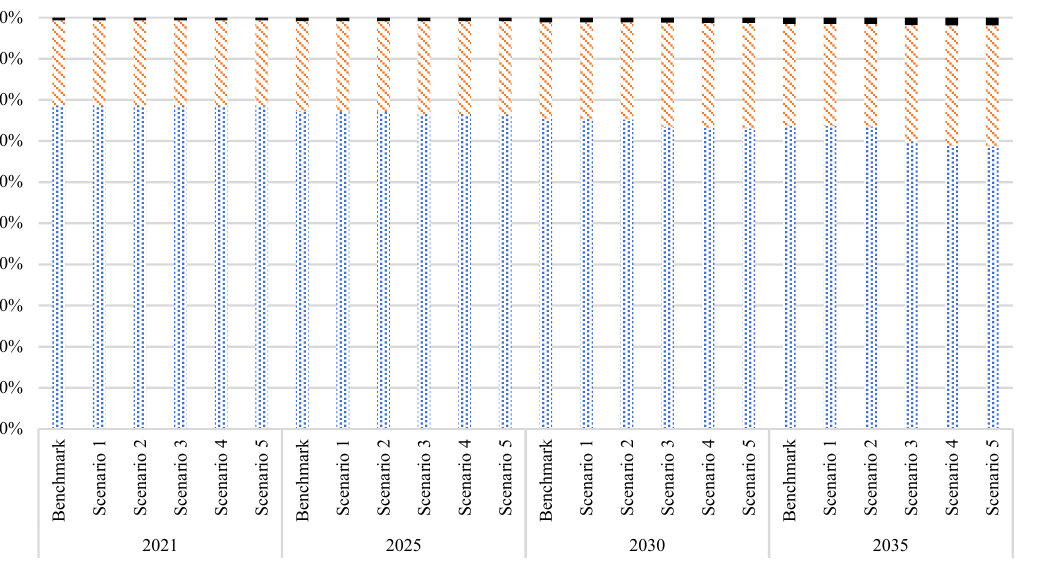
Figure 3. Carbon emissions simulation results of China’s energy consumption under different scenarios (100 million tons).